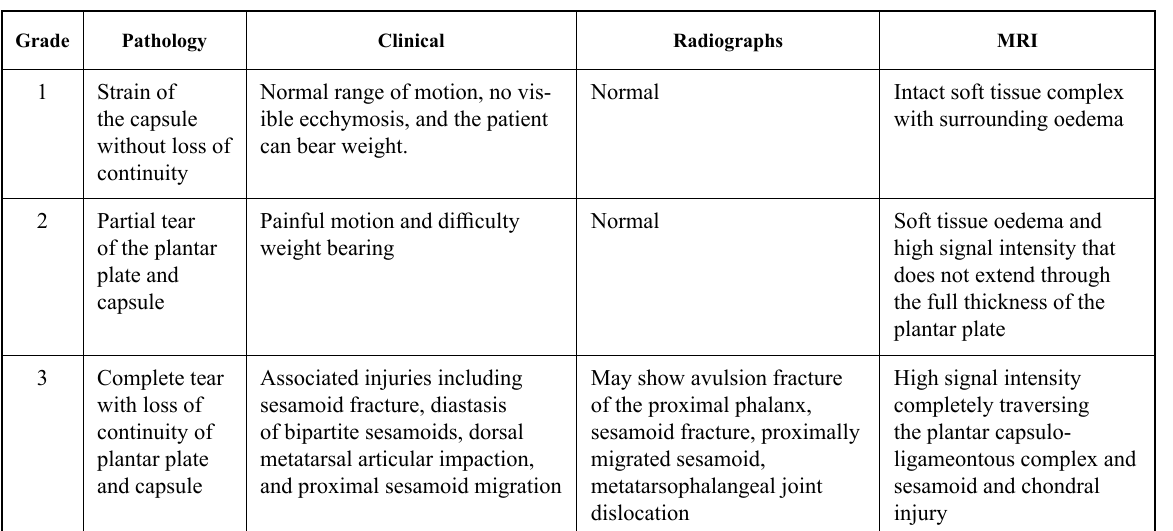
Table 1. Anderson turf toe classification